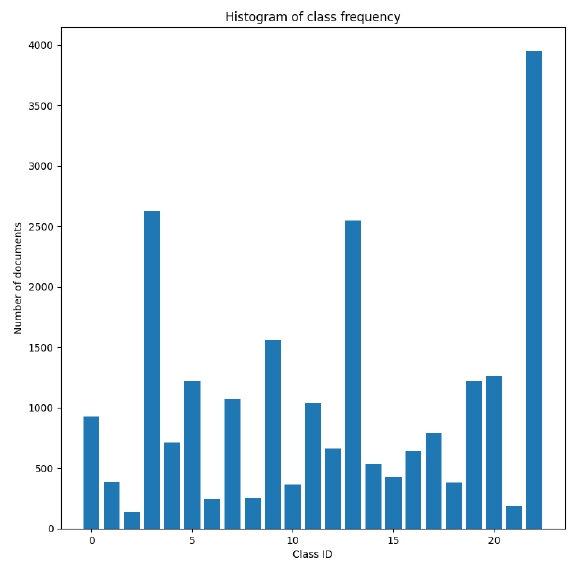
Figure 16. The length of documents is usually between 200 and 3000 words, according to Figure 17.